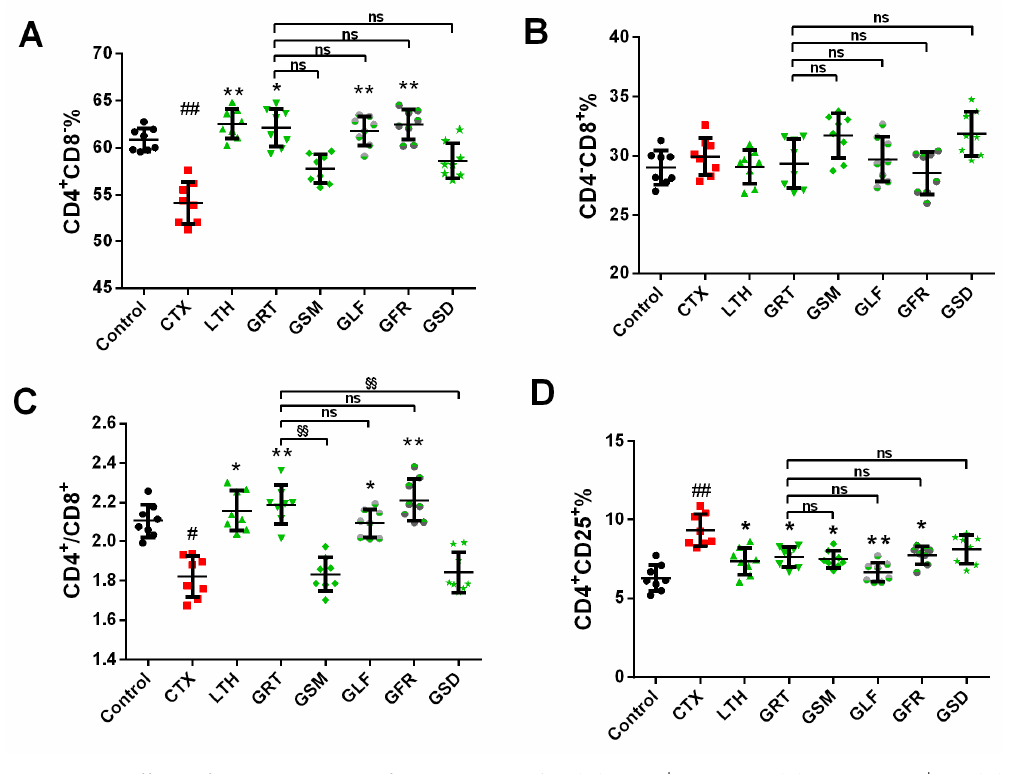
Figure 3. Effect of various parts of ginseng on the ( A ) CD4 + CD8 − %; ( B ) CD4 − CD8 + %; ( C ) CD4 + /CD8 + %; ( D ) CD4 + CD25 + %. The values are presented as mean ± SD, n = 10. ## p < 0.01 and # p < 0.05 compared with the control group. ** p < 0.01 and * p < 0.05 compared with the CTX group. §§ p < 0.01, ns p > 0.05 compared with the GRT group.